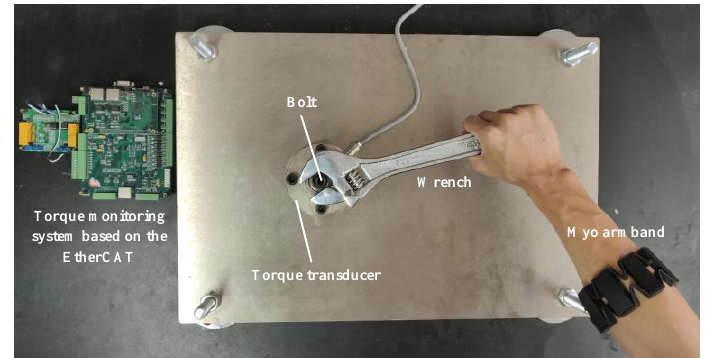
Figure 3. Bolt tightening test bench.